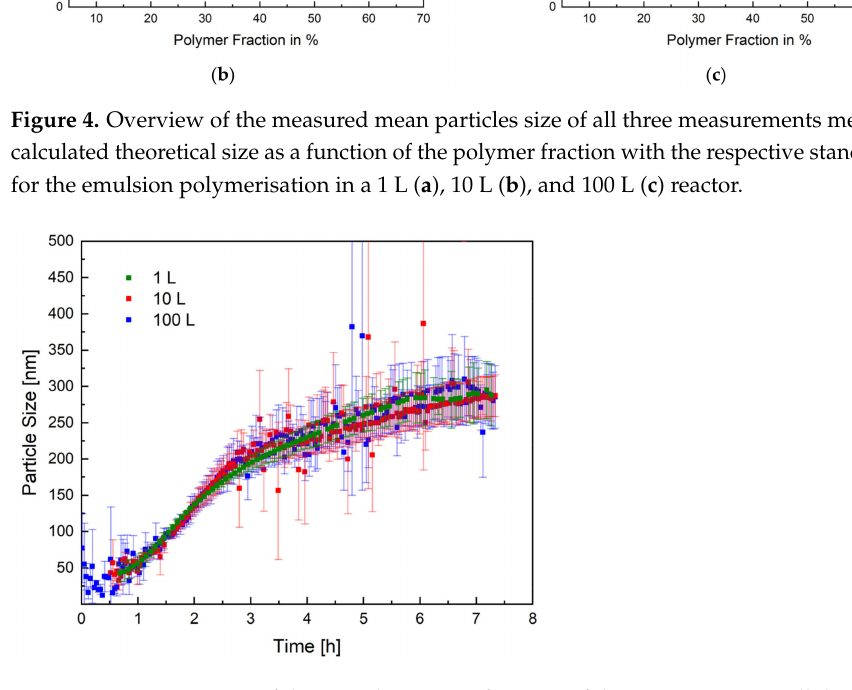
Figure 5. Representation of the particle size as a function of the reaction time in all three reactor sizes: 1 L (green), 10 L (red), and 100 L (blue). The standard deviation of each measurement is shown in the respective